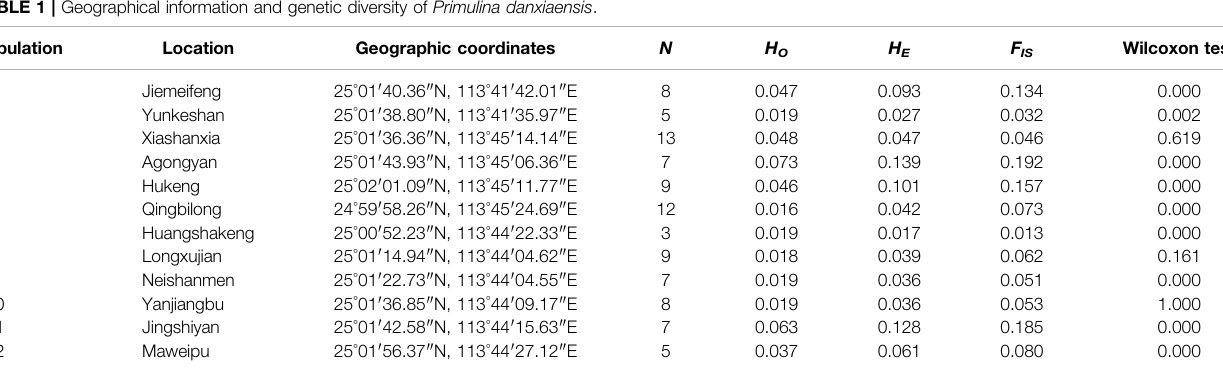
TABLE 1 | Geographical information and genetic diversity of Primulina danxiaensis